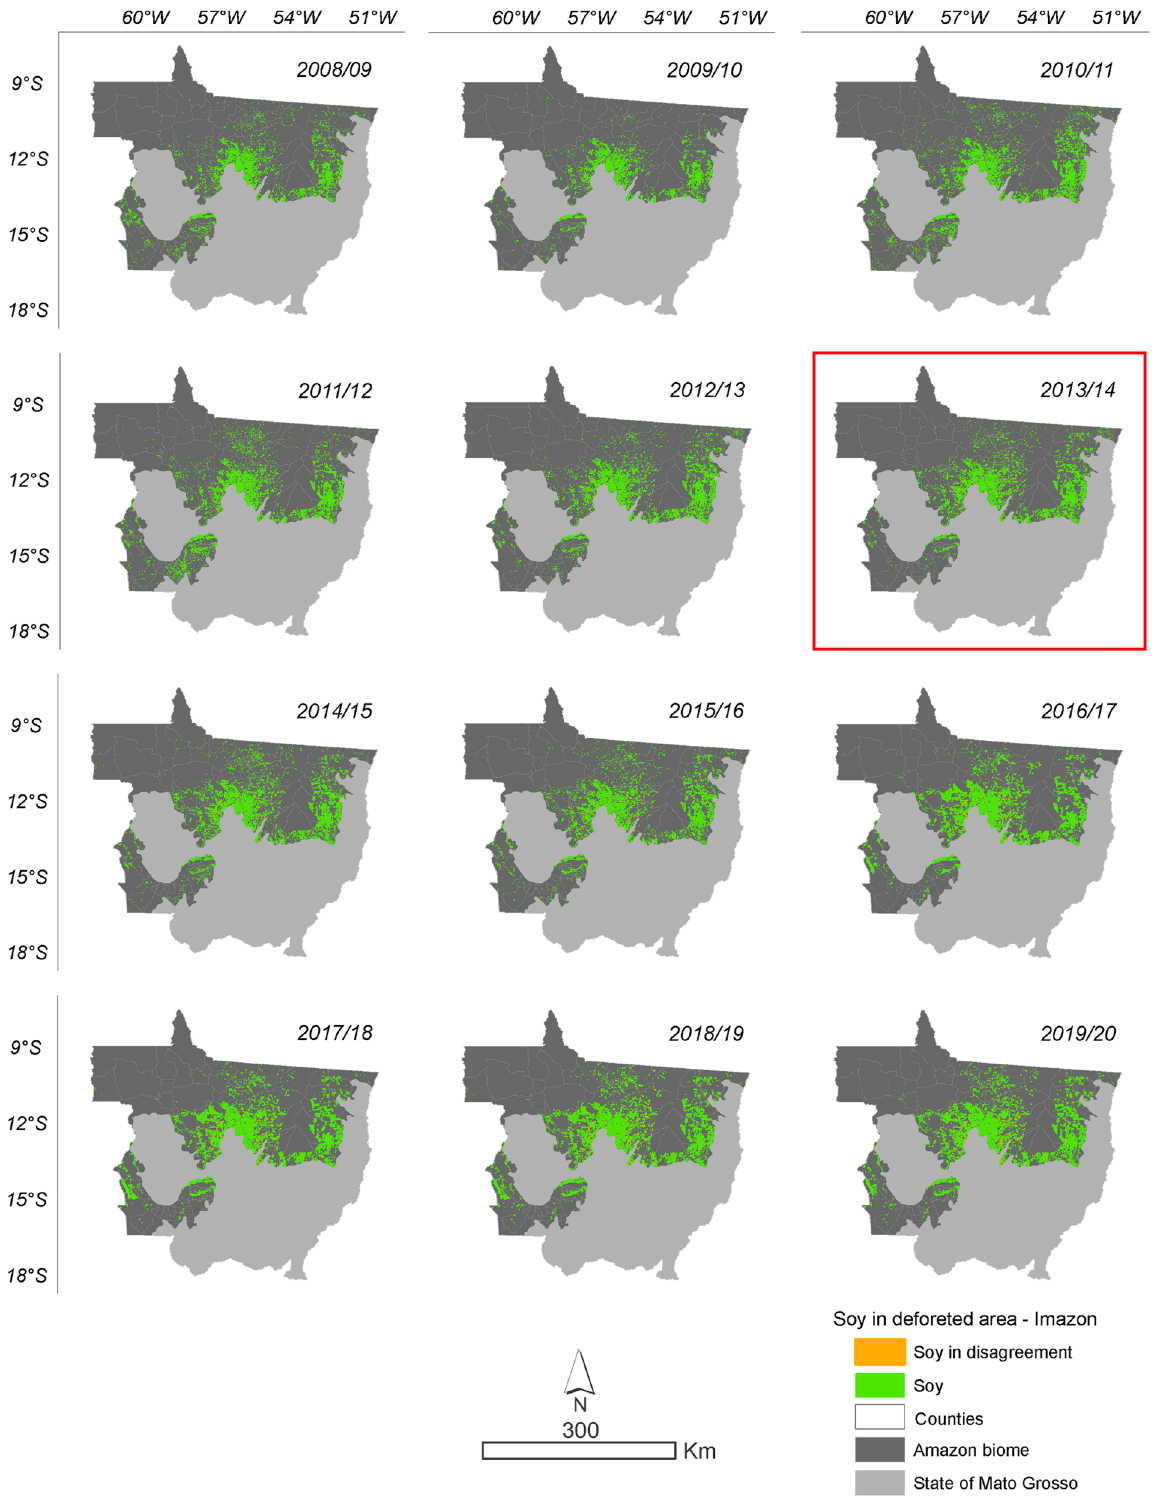
Figure 6. Soybean planted in the deforested area according to ImazonGeo deforestation data. The highlighted year corresponds to the likely point of change in the time series identified by the Pettitt test (Table